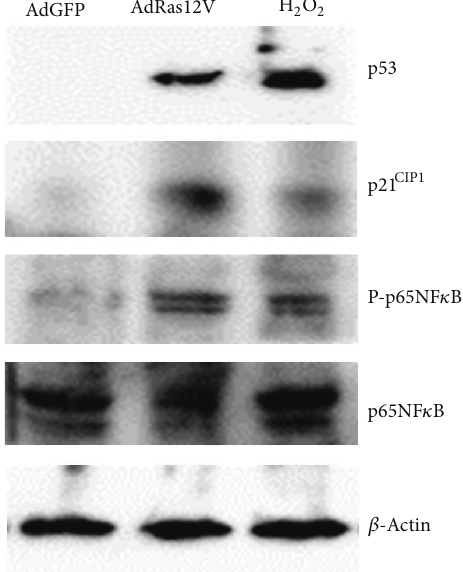
Figure 2: Western blot analysis of proteins extracted from HUVECs. HUVECs were infected with AdRas12V or treated with H 2 O 2 . Proteins were extracted from HUVECs 1 week after the treatment and analyzed by western blot